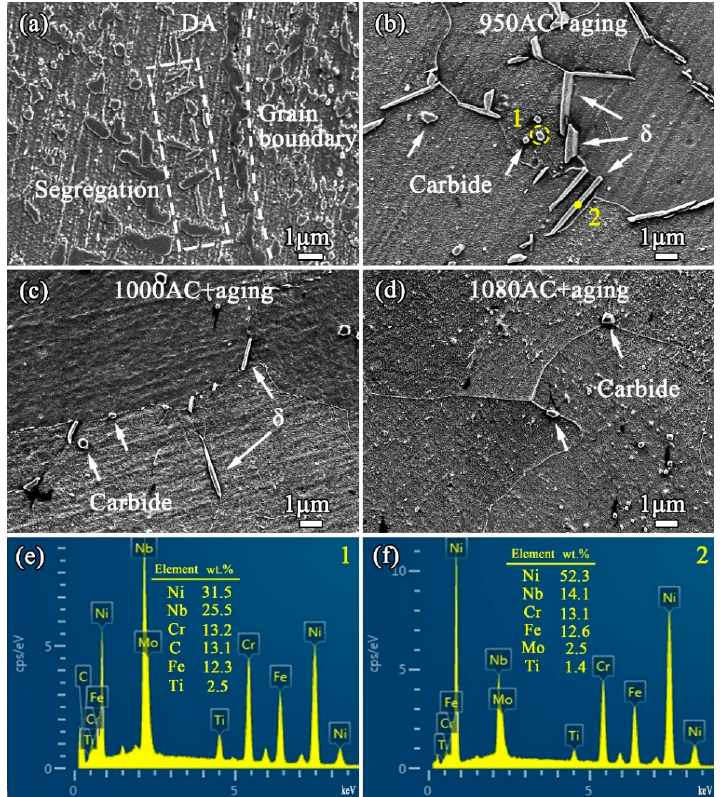
Figure 4. High-magnification scanning electron microscopy (SEM) micrographs of ( a ) DA, ( b ) 950AC + aging, ( c ) 1000AC + aging, and ( d ) 1080AC + aging samples. ( e ) and ( f ) are EDS spectra and elemental contents of the carbide and δ